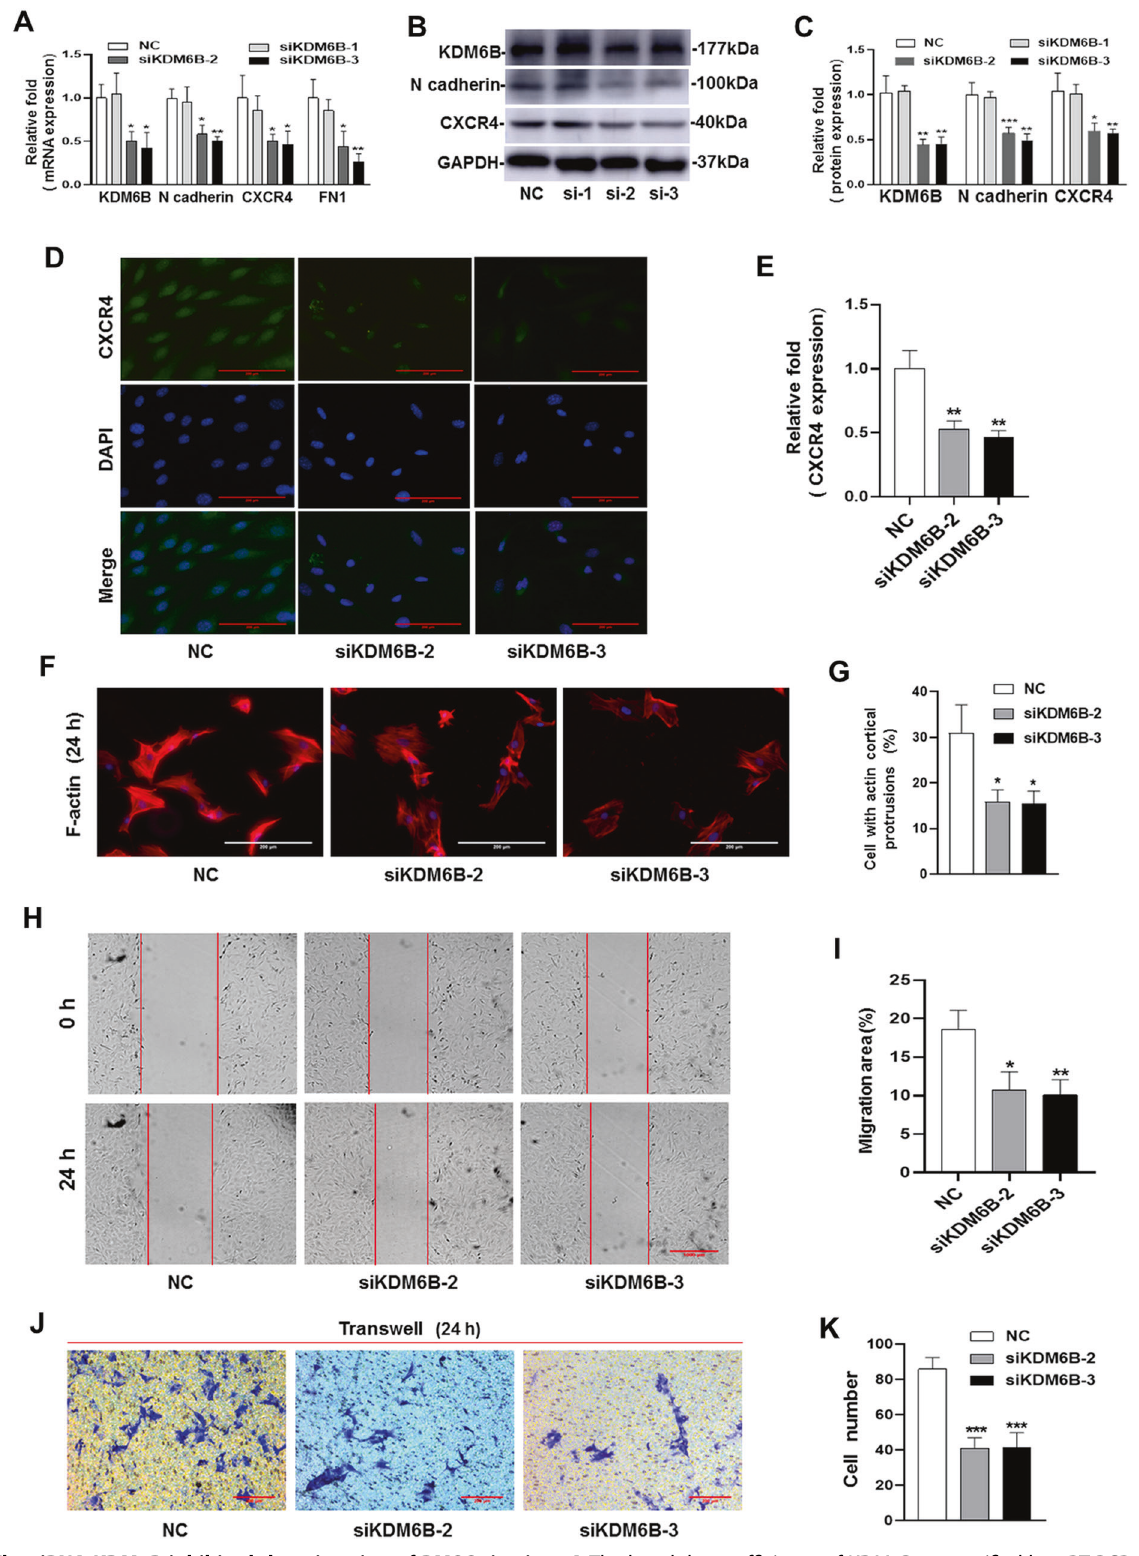
Fig. 1 The siRNA-KDM6B inhibited the migration of BMSCs in vitro. A The knockdown ef fi ciency of KDM6B was veri fi ed by qRT-PCR. B , C The siRNA-KDM6B inhibited the protein expression of migration-related genes (N cadherin and CXCR4). D , E The IF showed the expression of CXCR4 was inhibited by siRNA-KDM6B. F , G The siRNA-KDM6B inhibited the actin cortical protrusions formation of BMSCs. H , I The scratch test showed that siRNA-KDM6B decreased the migration area of BMSCs. J , K Transwell test veri fi ed that siRNA-KDM6B inhibited the migrated MSCs number. (si-1: siKDM6B-1, si-2: siKDM6B-2, si-3: siKDM6B-3. * P <0.05, ** P <0.01, *** P < 0.001 in comparison with the control group; ## P <0.01, ### P <0.001 in comparison with TGF - β 1 group. All experiments were repeated three times independently. All error bars ± standard deviation.).